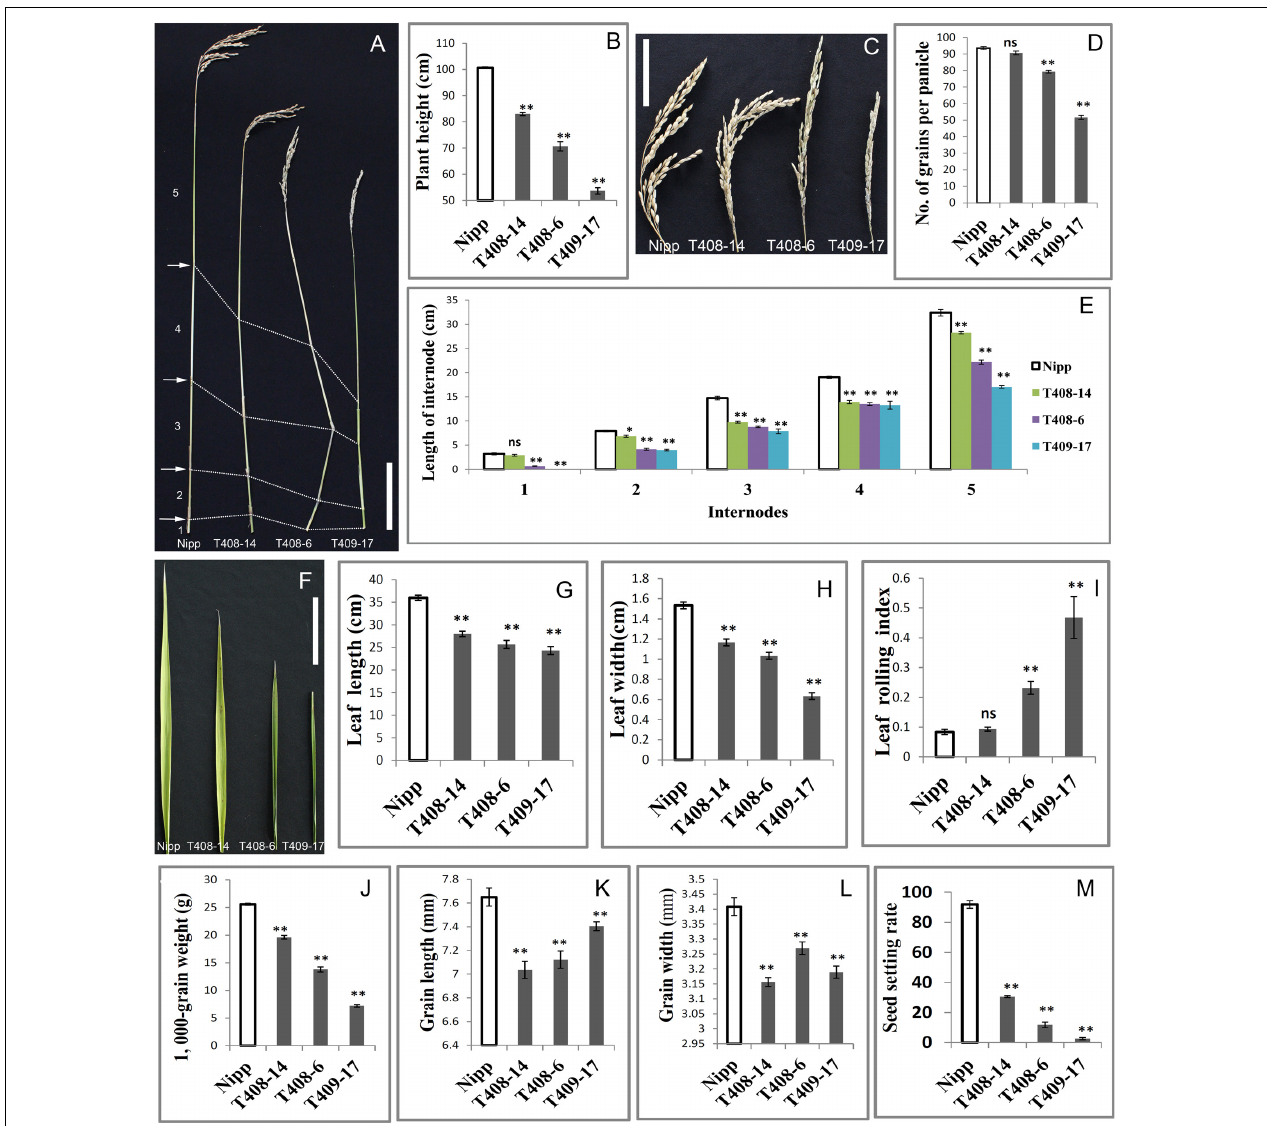
FIGURE 2 | Pleiotropic effects of OsGIF1 KO on rice development. Comparisons of several important traits between the OsGIF1 KO and control plants. (A) Stem; (B) plant height; (C) panicle; (D) number of grains per panicle; (E) internode length; (F) leaf; (G) flag leaf length; (H) flag leaf width; (I) leaf rolling index; leaf rolling index = ( L w – L n)/ L w; L w, distance of leaf blade margins at unfolding state; L n, distance of leaf blade margins at natural state; (J) 1000-grain weight; (K) grain length; (L) grain width; and (M) seed setting rate. Scale bars: 10 cm. Values are all shown as means ± standard error of the mean (SEM) ( n = 3). Asterisks indicate significant differences between the WT and KO plants as determined by Student’s t -test: ns, not significant; ∗∗ p ≤ 0.01; ∗ p ≤